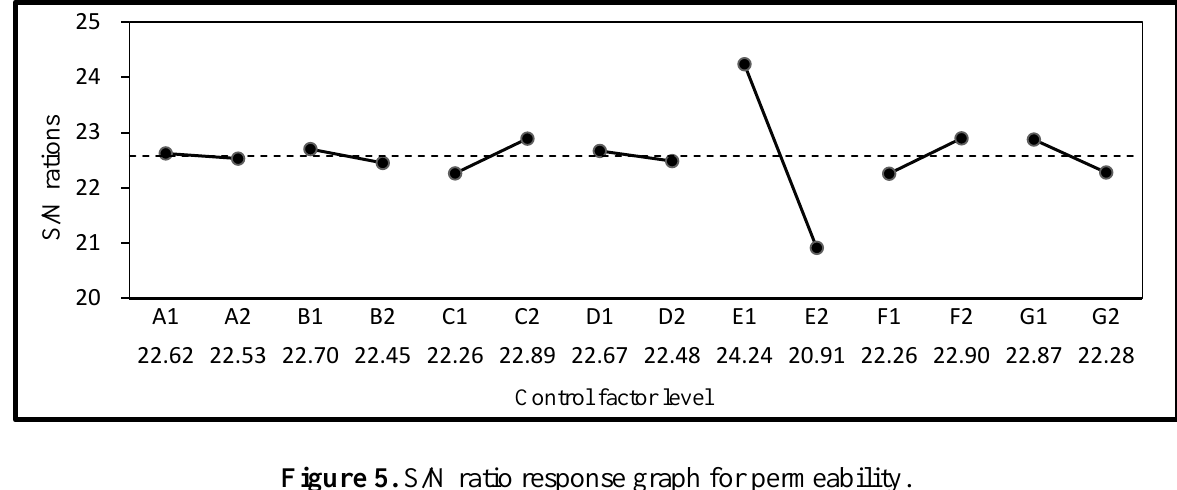
Figure 5. S/N ratio response graph for